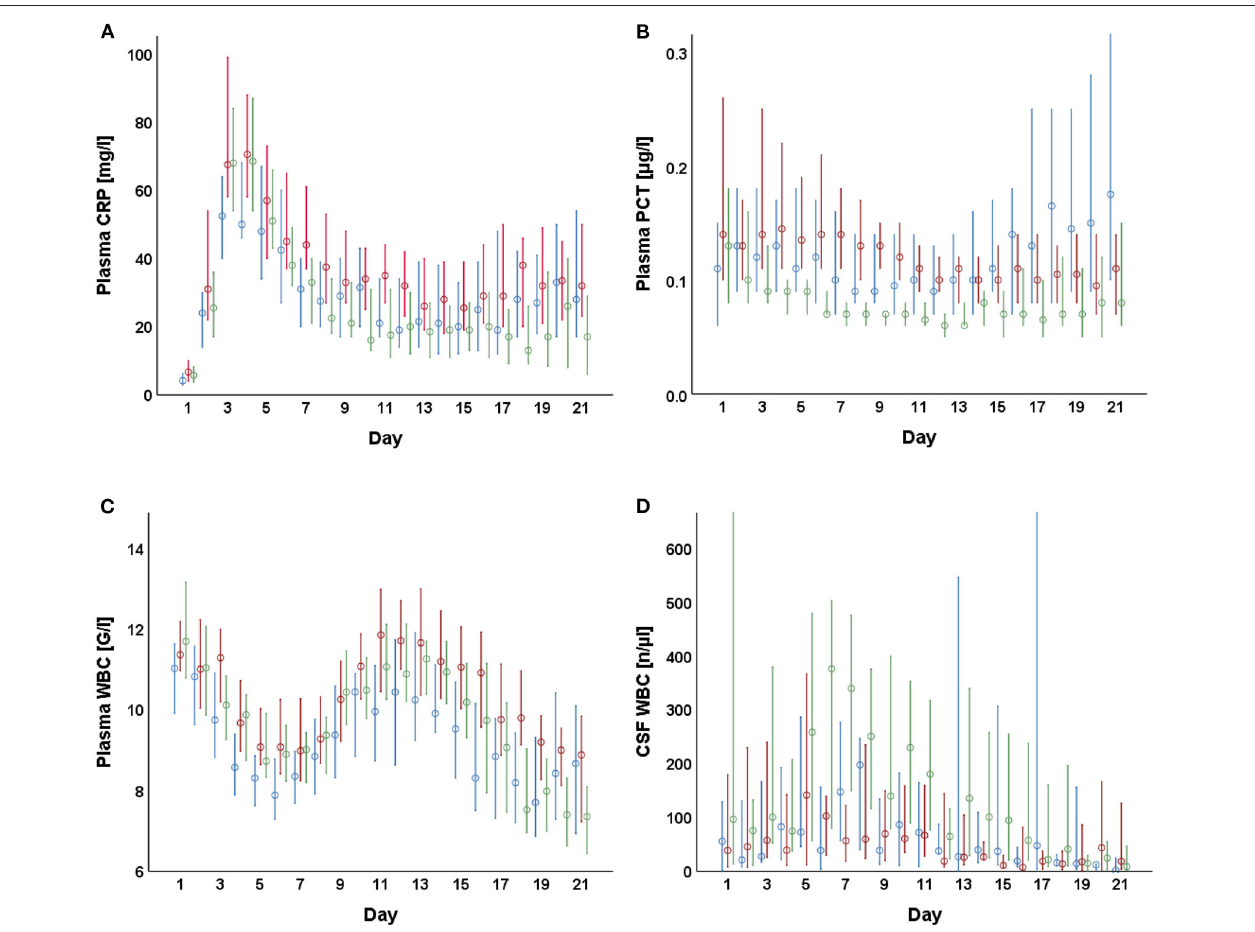
FIGURE 1 | Plasma and cerebrospinal fluid (CSF)-derived parameters after external ventricular drain (EVD) insertion. Median daily values including the 95% confidence interval between day 1 and 21 are shown for CRP (A) , PCT (B) , plasma WBC (C) , as well as CSF WBC (D) grouped by control (blue), control with non-cerebral infection (red), and VRI